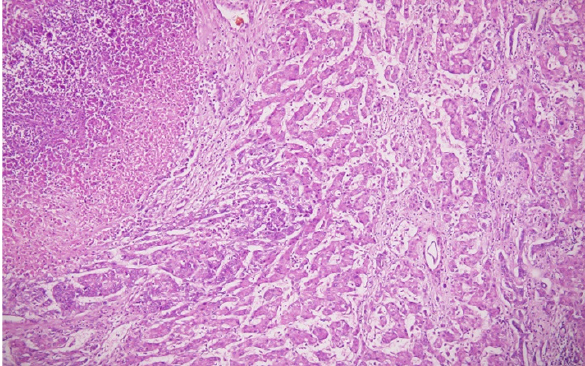
Figure 3: Fetal pattern with tumor cells arranged in thin trabeculae and adjacent areas show necrosis (HE stain,